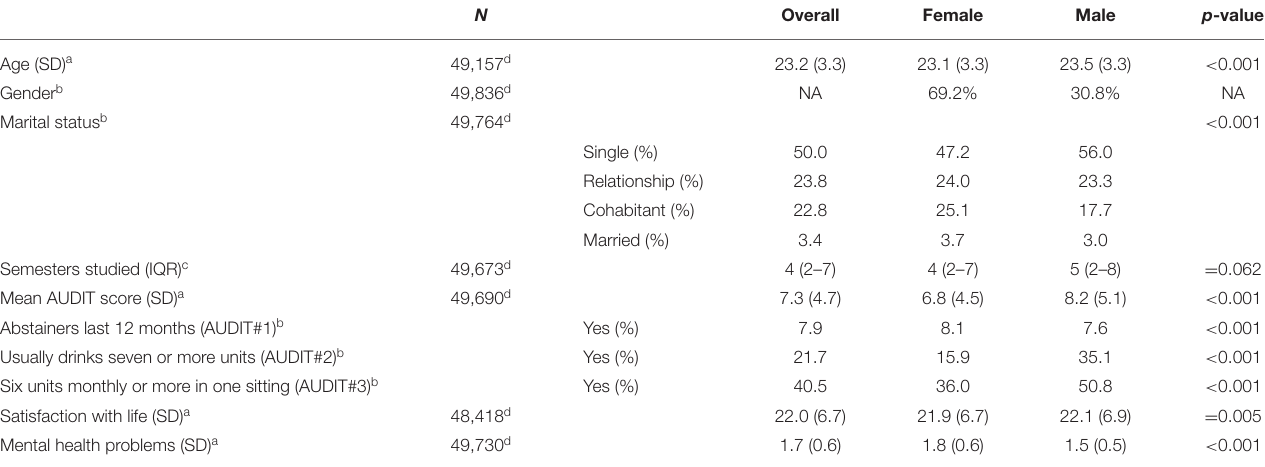
TABLE 1 | Overall characteristics of sample across gender.